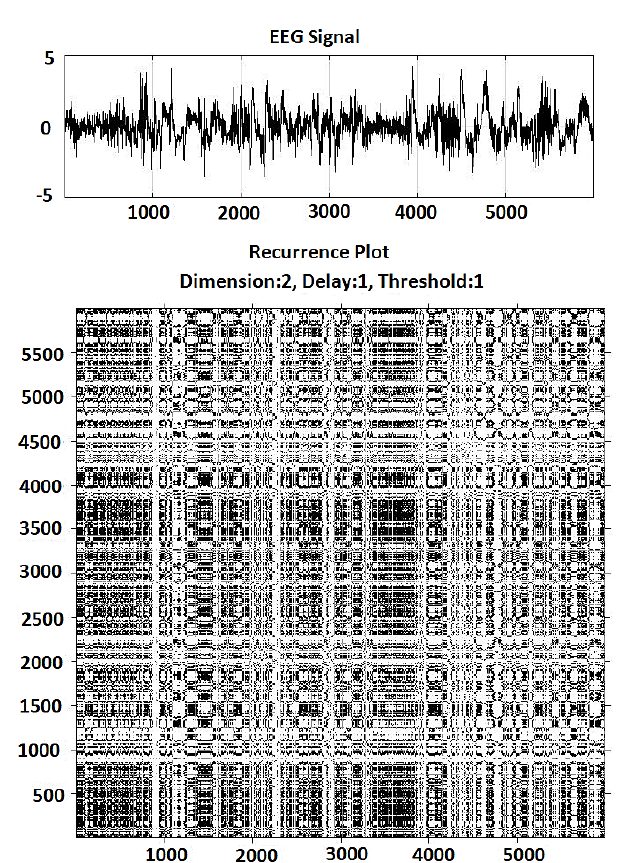
Fig. 3. Recurrence plot of EEG signals during sleep